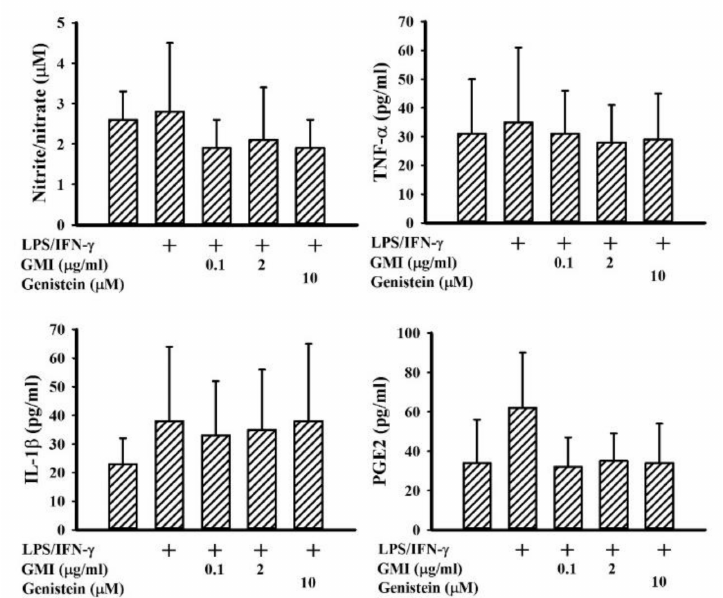
Figure 6. LPS/IFN- γ and GMI failed to alter inflammatory mediator production in astrocyte cultures. Astrocyte cultures were pretreated with vehicle, various concentrations of GMI (0.1 and 2 µ g/mL), or genistein (10 µ M) for 30 min. before being incubated with LPS (100 ng/mL)/IFN- γ (10 U/mL) for an additional 24 h. Supernatants were collected and subjected to Griess reagent or ELISA for the measurement of NO, TNF- α , IL-1 β , and PGE2. n = 4. The + means the groups treated with LPS/IFN- γ and the rest groups without + indicate vehicle